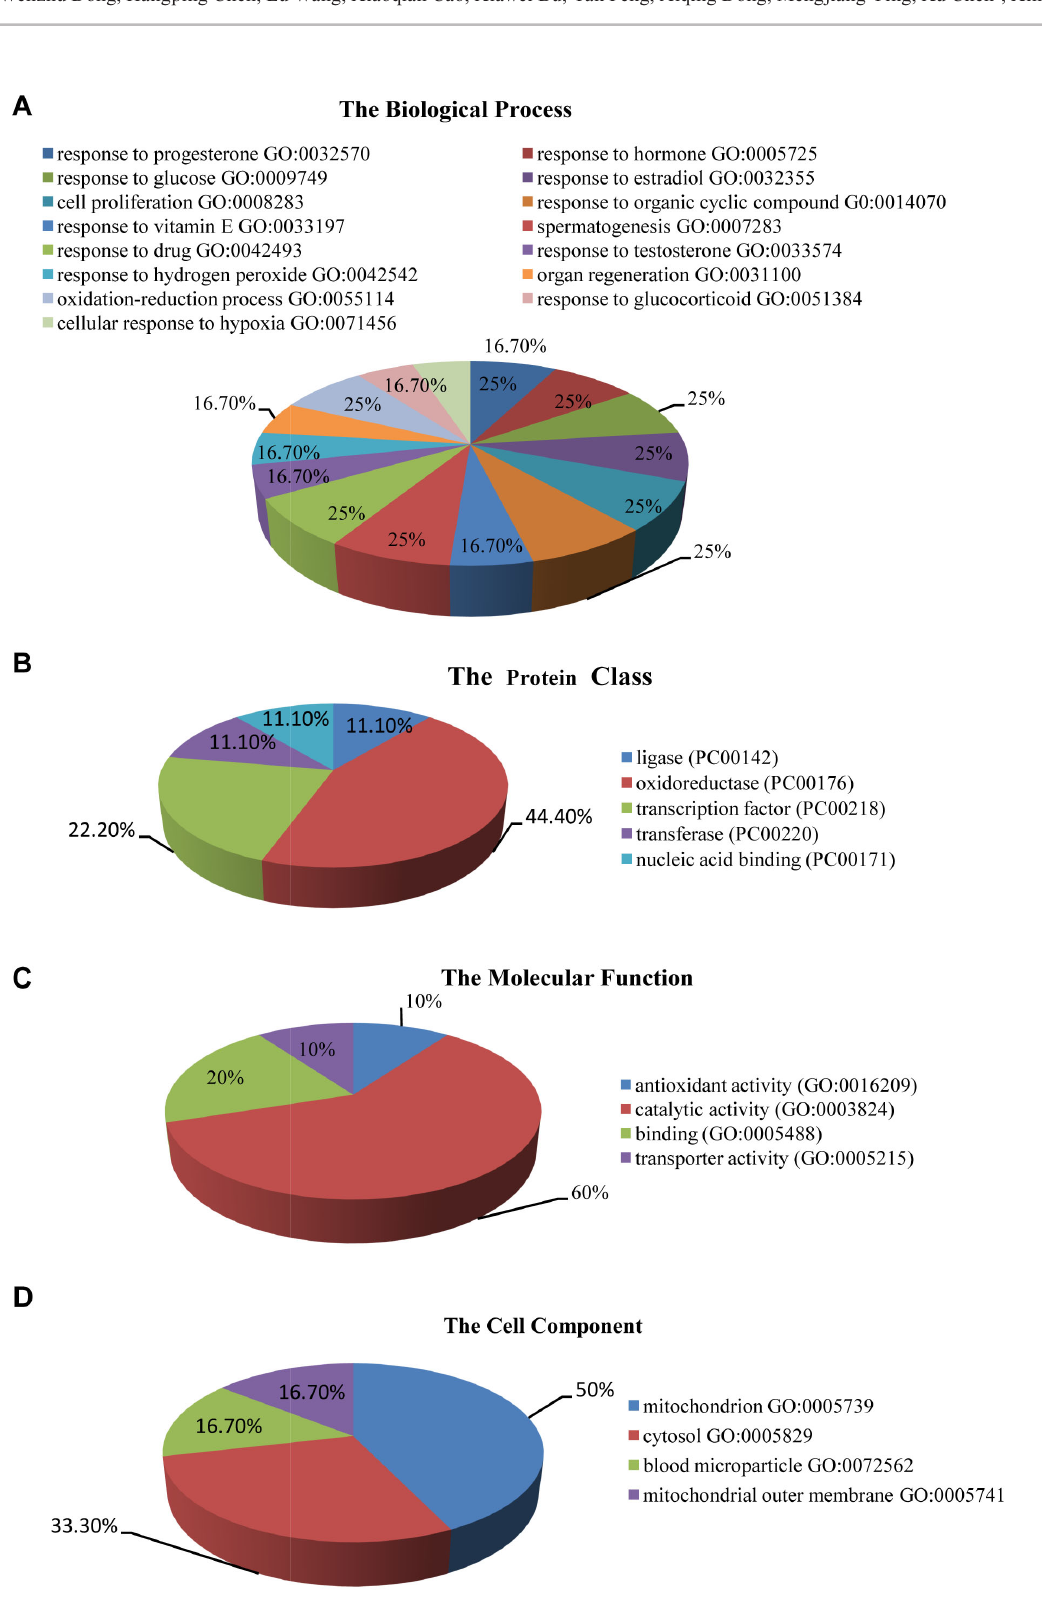
FIGURE 4 - Biological Process analysis based on DAVID data bank and GO enrichment analysis of differentially expressed genes. (A) Biological Process enrichment; (B) Protein Class analysis; (C) Molecular Function enrichment; (D) Cell Component